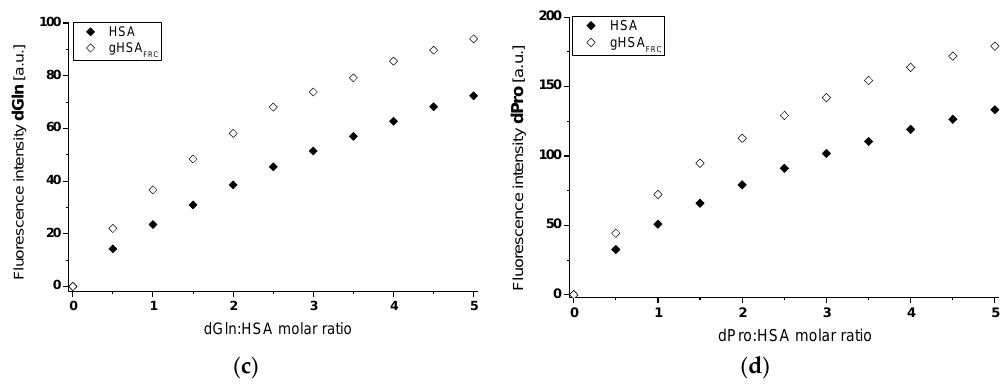
Figure 7. The binding capacity of fluorescent probes ( a ) DNSA, λ ex = 350 nm, λ em ~ 475 nm, ( b ) WAR, λ ex = 330 nm, λ em ~ 389 nm, ( c ) dGln, λ ex = 350 nm, λ em = 475 nm and ( d ) dPro, λ ex = 350 nm, λ em = 475 nm to non-glycated and glycated human serum albumin, protein concentration equals 5 × 10 −6 mol∙L −1 ; t = 37 °C.